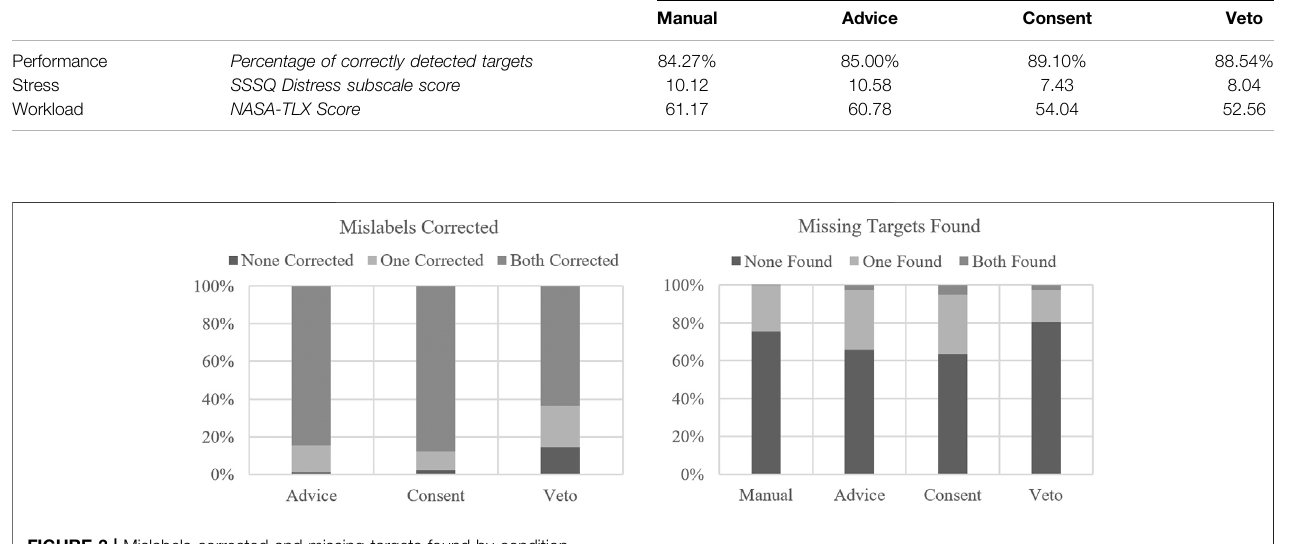
FIGURE 3 | Mislabels corrected and missing targets found by